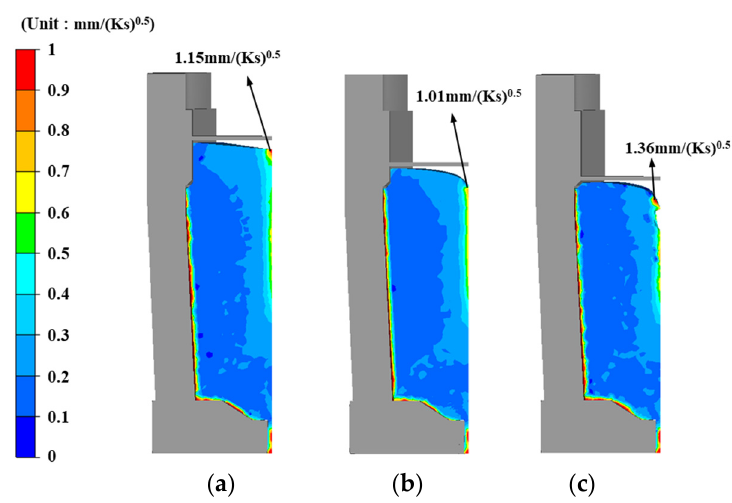
Figure 4. Ny ‒ 1 for ( a ) 16% hot top; ( b ) 8% hot top; ( c ) free hot top. Figure 4. Ny − 1 for ( a ) 16% hot top; ( b ) 8% hot top; ( c ) free hot top.